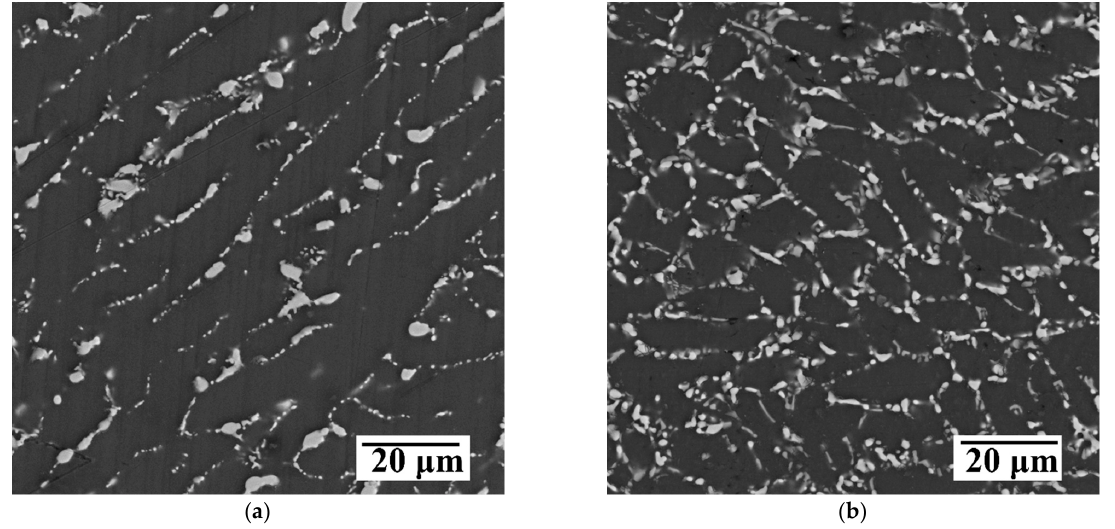
Figure 9. SEM microstructure of the alloys: ( a ) Al10Cu0.5Ca and ( b ) Al10Cu1.5Ca after homogenization annealing at 530 °C for 12 h. Table 4. The measured chemical composition of the aluminum matrix (Al) after homogenization and calculated fractions of extra phases.